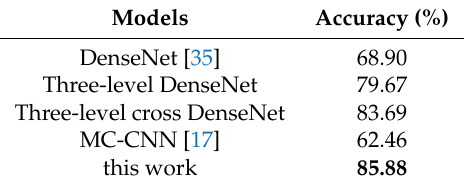
Table 5. Compared with the state-of-the-art approaches in accuracy, the best result is in